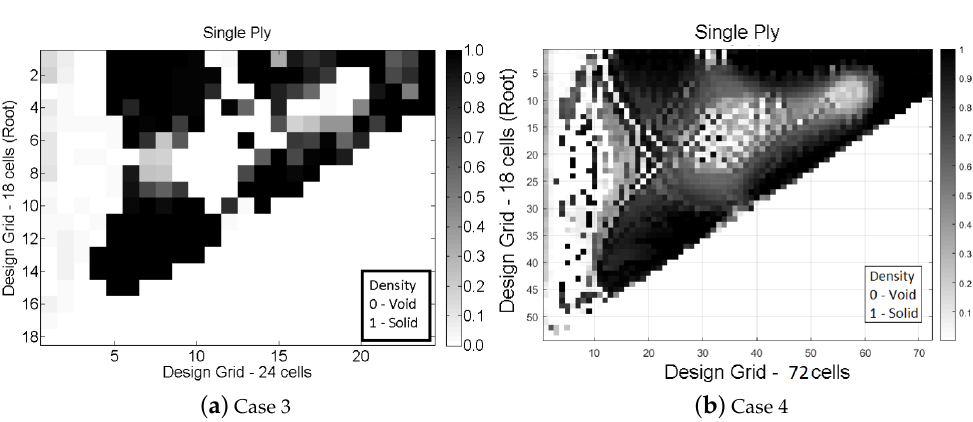
Figure 11. Topology optimization solutions of Cases 3 and